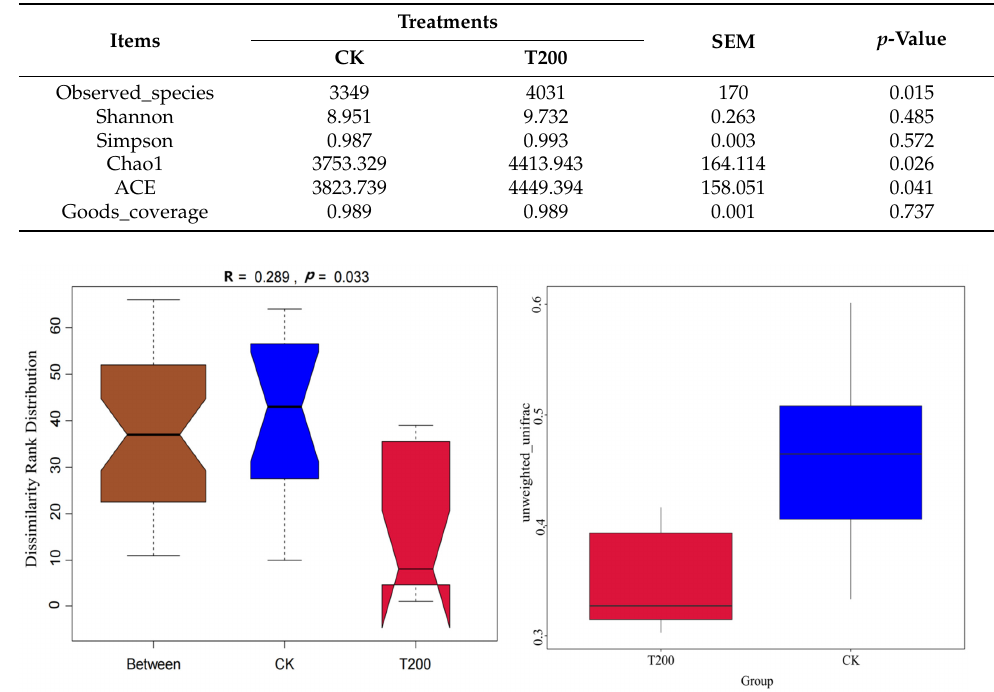
Figure 1. Beta diversity analyses of microbial communities in the rhizosphere soil using anosim and Unweighted_UniFrac. The boundary in the figure represents the upper and lower interquartile intervals (IQR), the horizontal line represents the median, and the upper and lower whiskers in the left figure represent 1.5 times the IQR range beyond the upper and lower interquartile, respectively. “Between” indicates the difference between groups; the thickness represents the sample size. If the gaps in each block diagram are inconsistent with each other, this implies that the median value of each group is different.